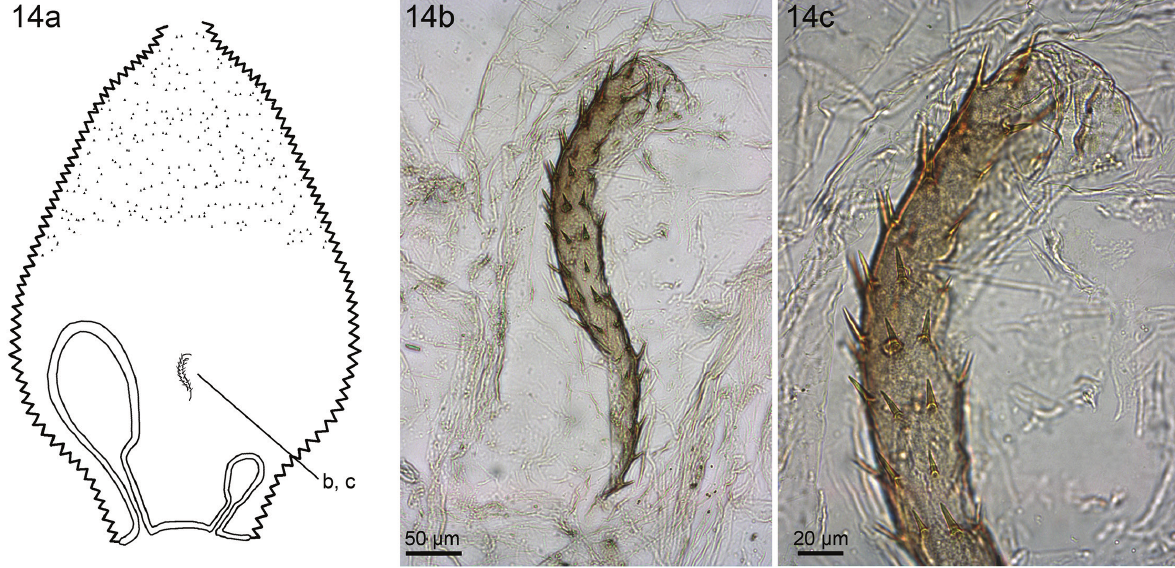
Figure 14. Labiotermes leptothrix . (a) Schematic drawing of P1 showing arrangement of spines. (b, c) Photomicrographs: (b) Detail of central ridge structure; (c) Detail of spines on central